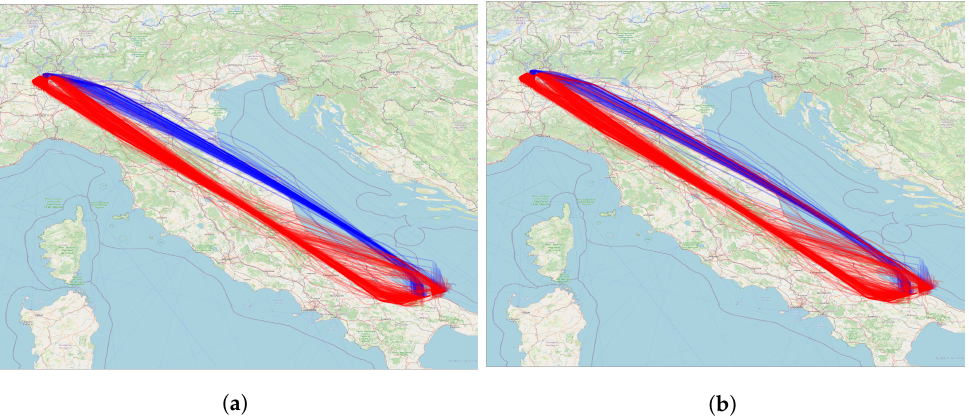
Figure 9. Trajectories, clusters and distribution of trajectories between airlines serving Milan Malpensa and Bari OD. ( a ) Cluster 0 (blue) and cluster 1 (red) trajectories; ( b ) Airline 1 (red) and Airline 2 (blue)